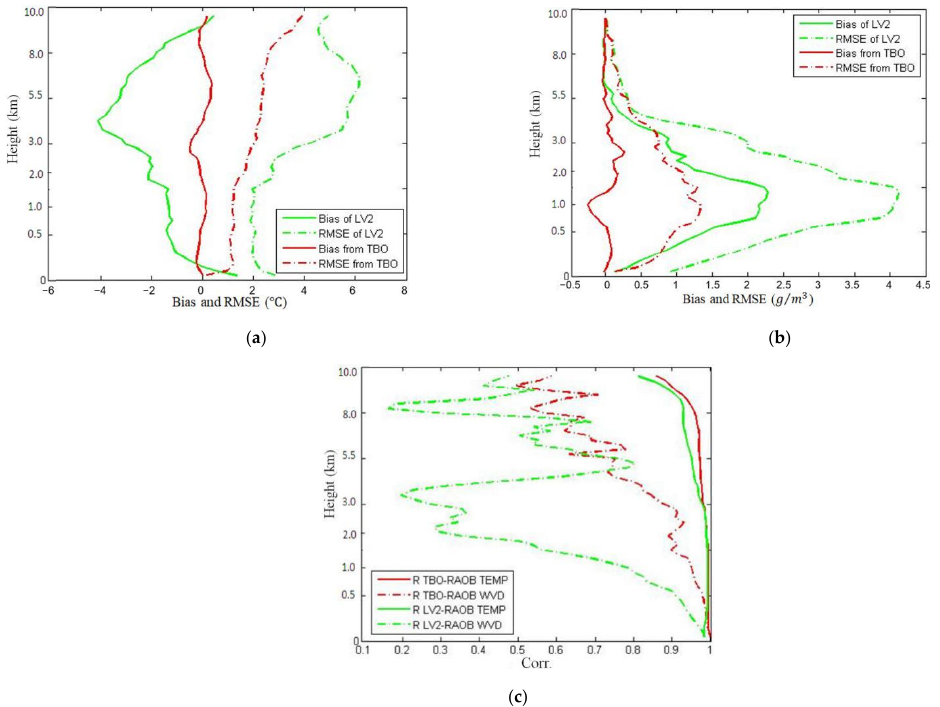
Figure 1. Statistics of temperature and humidity profiles as compared with radiosonde observations (RAOB) (green line, LV2; red line, ˆ f − TB O ). ( a ) bias and root of mean squared error (RMSE) for temperature; ( b ) bias and RMSE for humidity; ( c ) correlation coefficients.